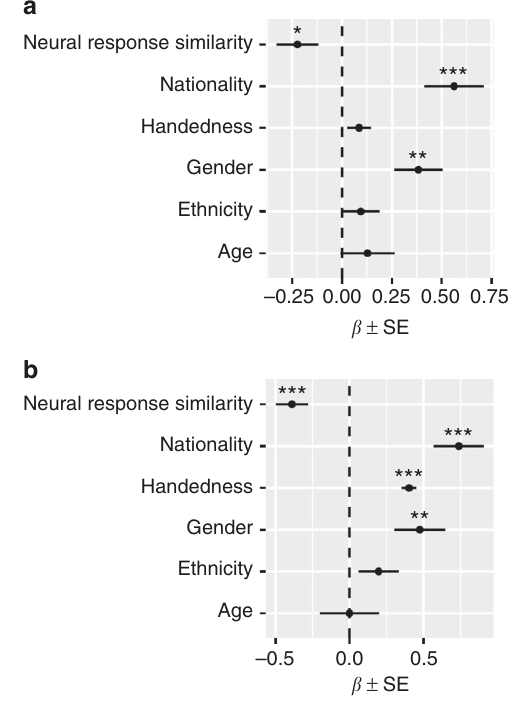
Fig. 5 Regression coef fi cients from models predicting social distance and friendship status. Regression coef fi cients correspond to weighted average neural response similarities and dissimilarities in control variables. a Illustration of regression coef fi cients from an ordered logistic regression model in which social distance was predicted based on the similarity of participants ’ neural response time series, as well as dissimilarities in control variables. b Illustration of regression coef fi cients from a logistic regression model in which friendship status was predicted based on the similarity of participants ’ neural response time series, as well as dissimilarities in control variables. Error bars indicate standard errors of the regression coef fi cients estimated using multi-way clustering to account for dyadic dependencies